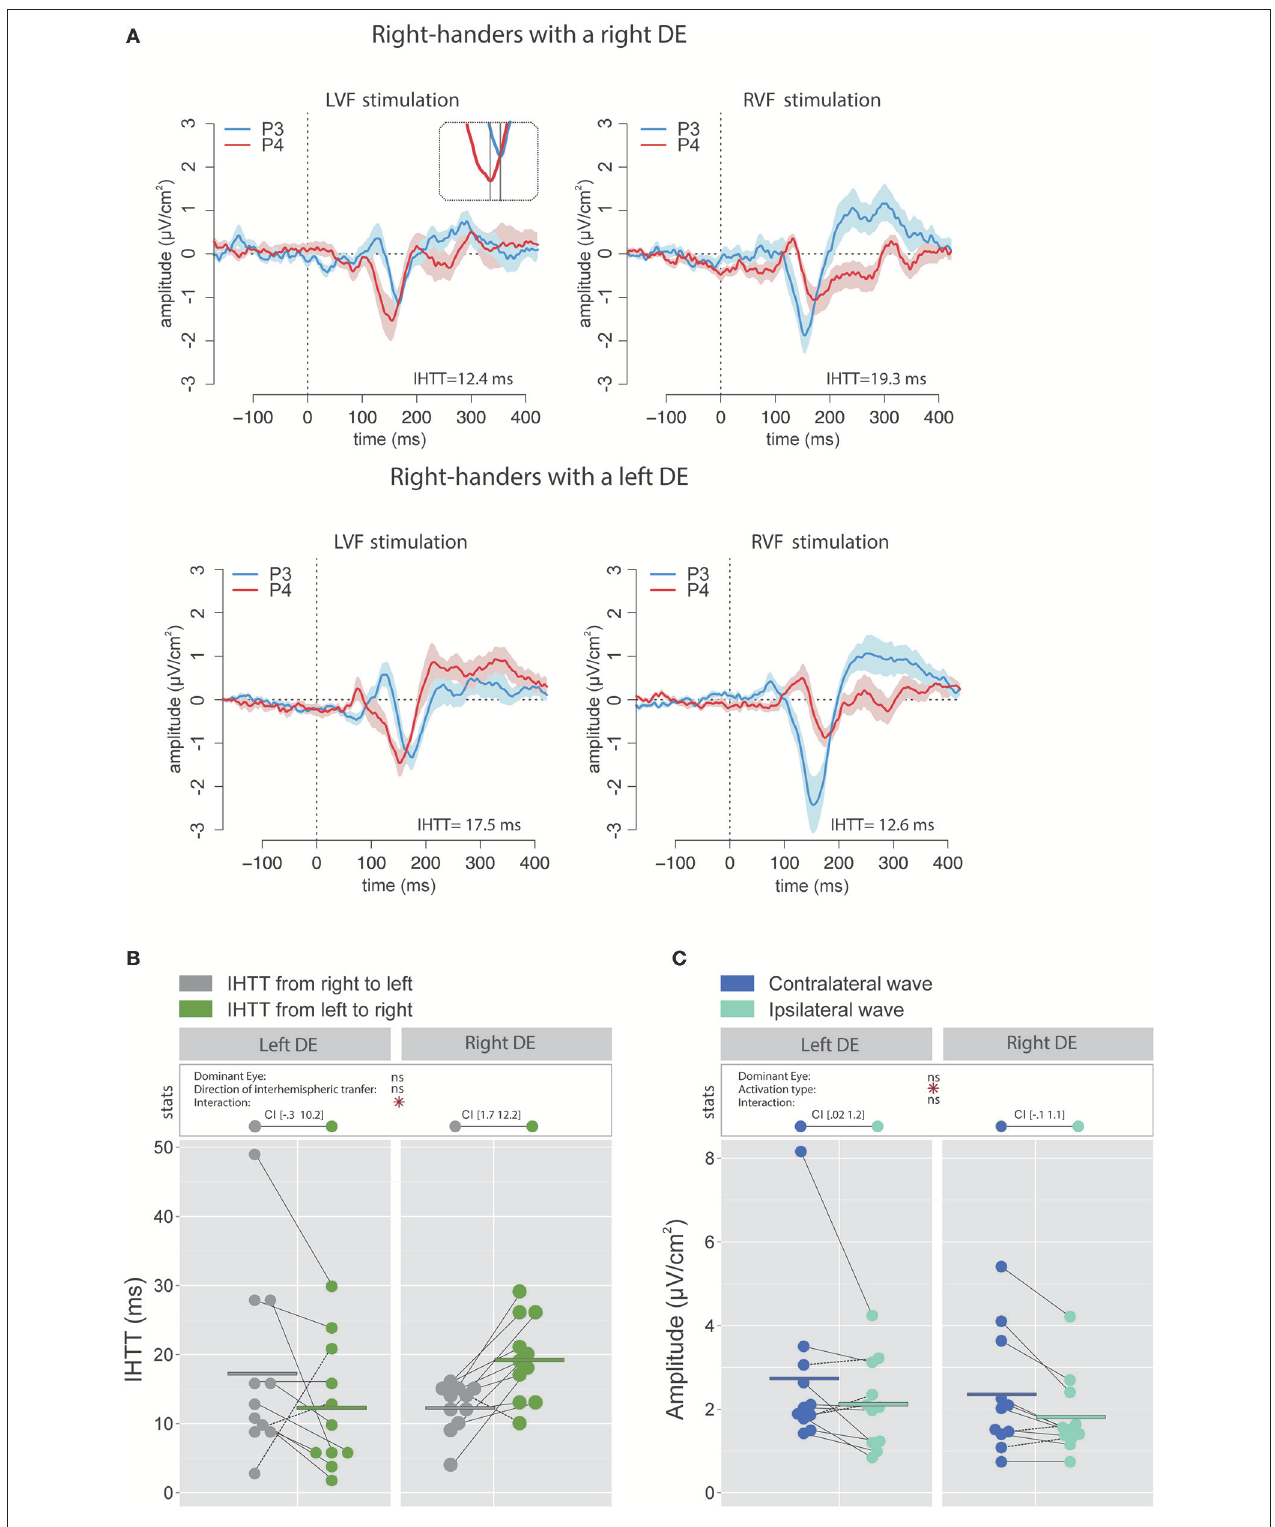
FIGURE 3 | Waveforms and average results computed over posterior sites after Laplacian transformation in right-handers. (A) Grand average CSD waveforms recorded over P3 (blue waves) and P4 (red waves) electrodes in the two experimental conditions (LVF or RVF stimulation). Shading blue and red areas represent